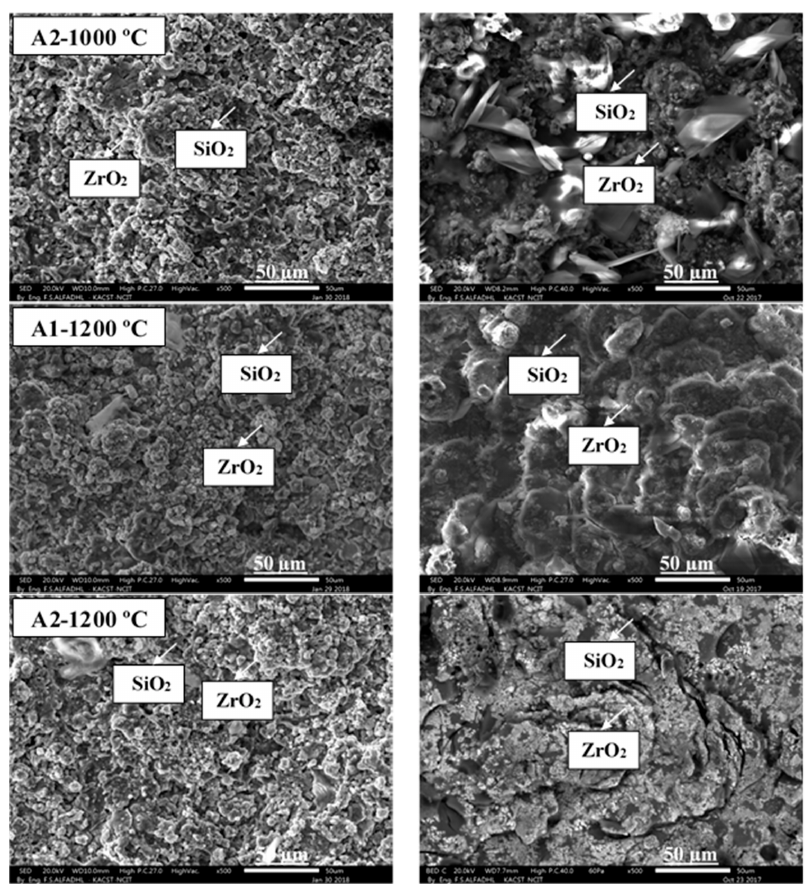
Figure 12. Secondary electron SEM microstructure of the A1 and A2 with different surface treatment conditions torch ( left ) and furnace ( right ) at 800 °C, 1000 °C and 1200 °C coatings taken at 20 kV electron acceleration voltage at 500× (scale bar = 50 μ m) magnifications.